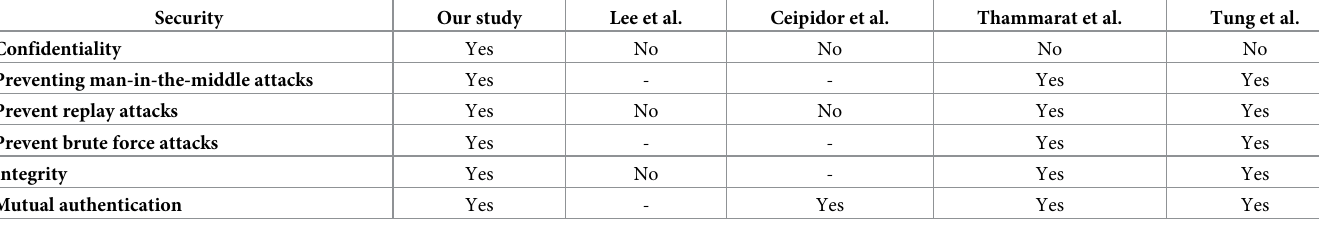
Table 3. Comparison of safety